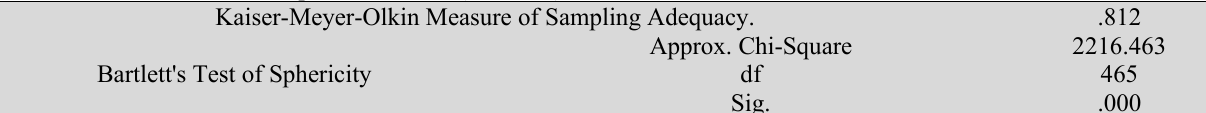
KMO and Bartlett's Test for independent factors (11 th time) Kaiser-Meyer-Olkin Measure of Sampling Adequacy.